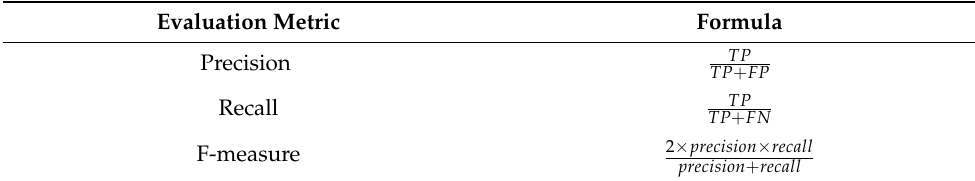
Table 3. Performance metrics to compare prediction